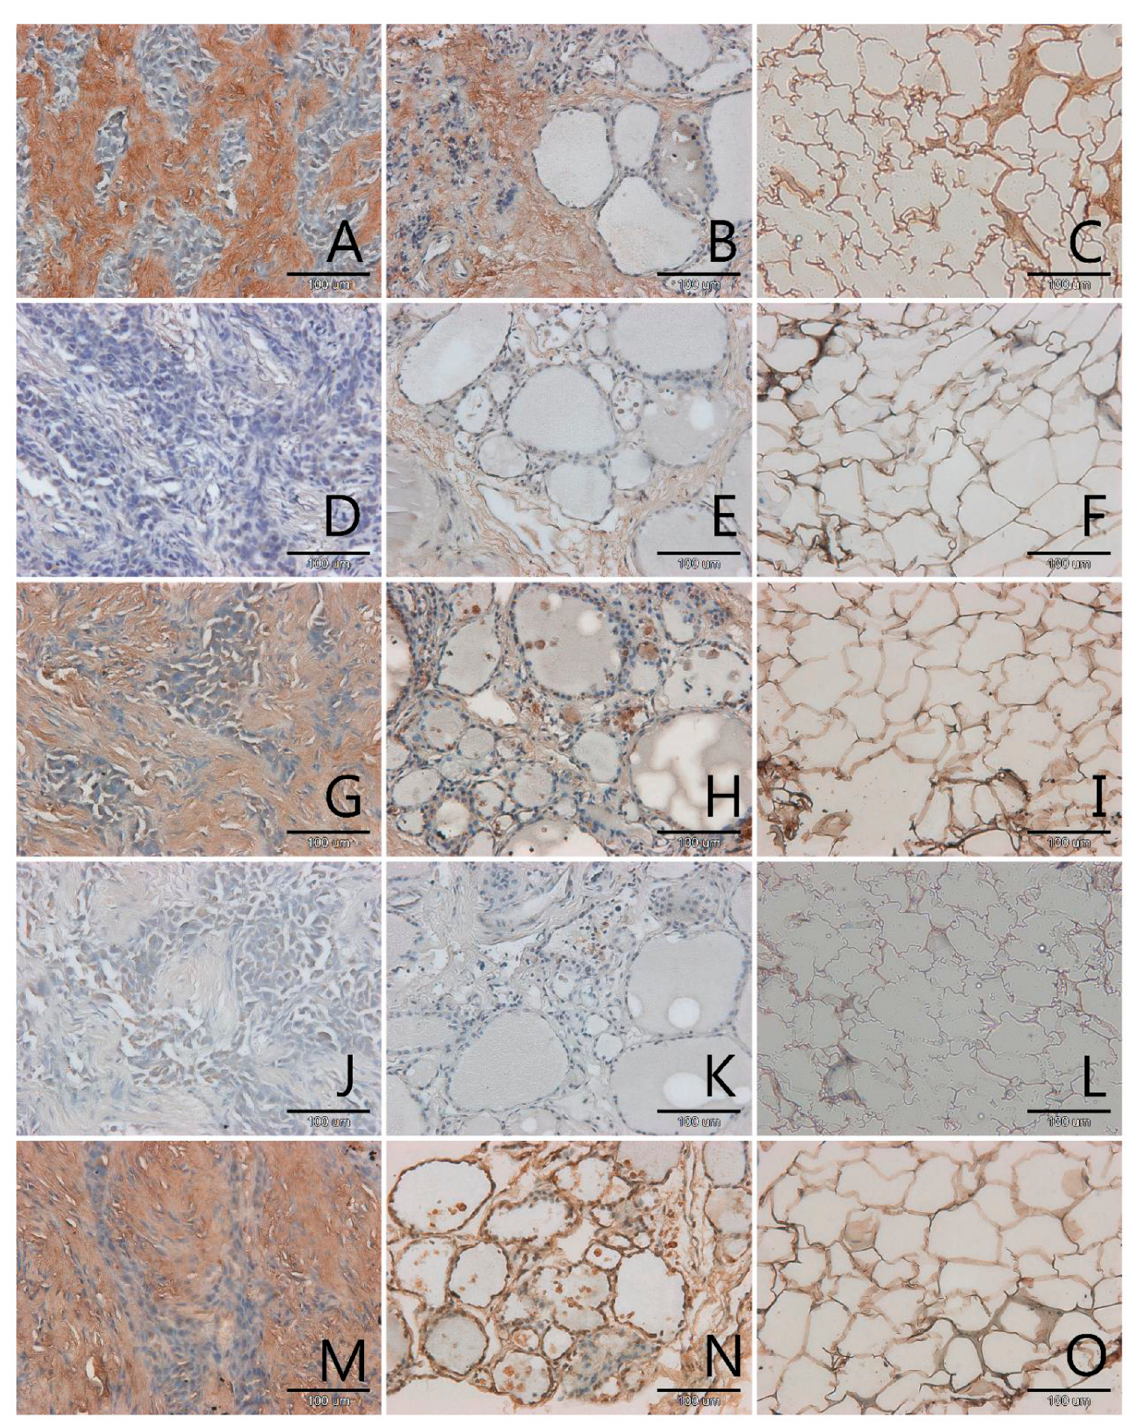
Figure 1. Immunohistochemical detection of advanced glycation end-products (AGEs) ( A – C ), receptors for advanced glycation end-products (RAGE) ( D – F ), scavenger receptor class (SR)-A ( G – I ), (SR)-BI ( J – L ) and nitric oxide synthase-3 (NOS-3) ( M – O ) in sections of the thyroid gland with papillary cancer ( A , D , G , J , M ), in the paired control sections ( B , E , H , K , N ) and in the fatty tissue surrounding the tumor ( C , F , I , L , O ). Magnification 200× (scale bar 100 µm).